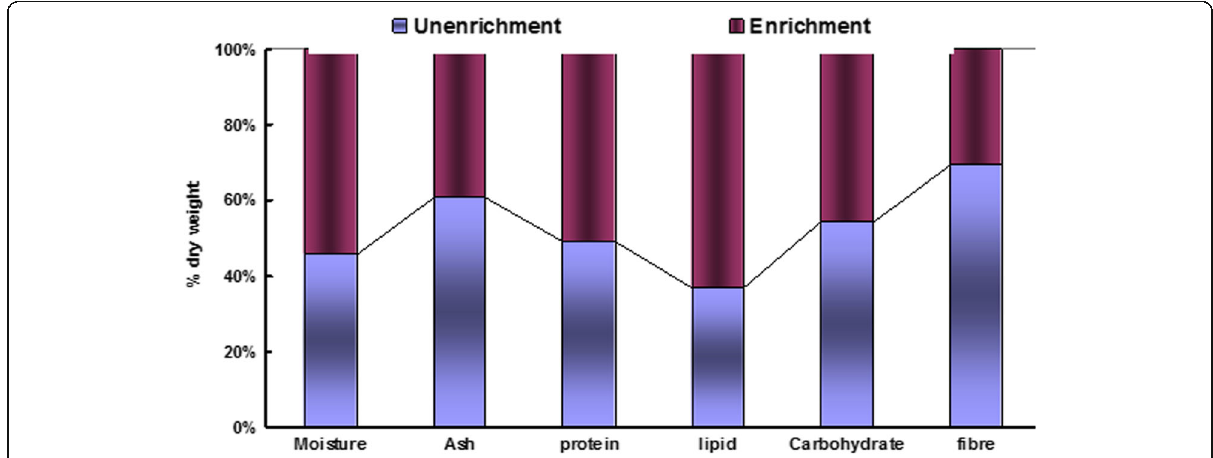
Fig. 1 Biochemical composition (% dry weight) in newly hatched (unenrichment) and enrichment (24 h) Artemia tunisiana